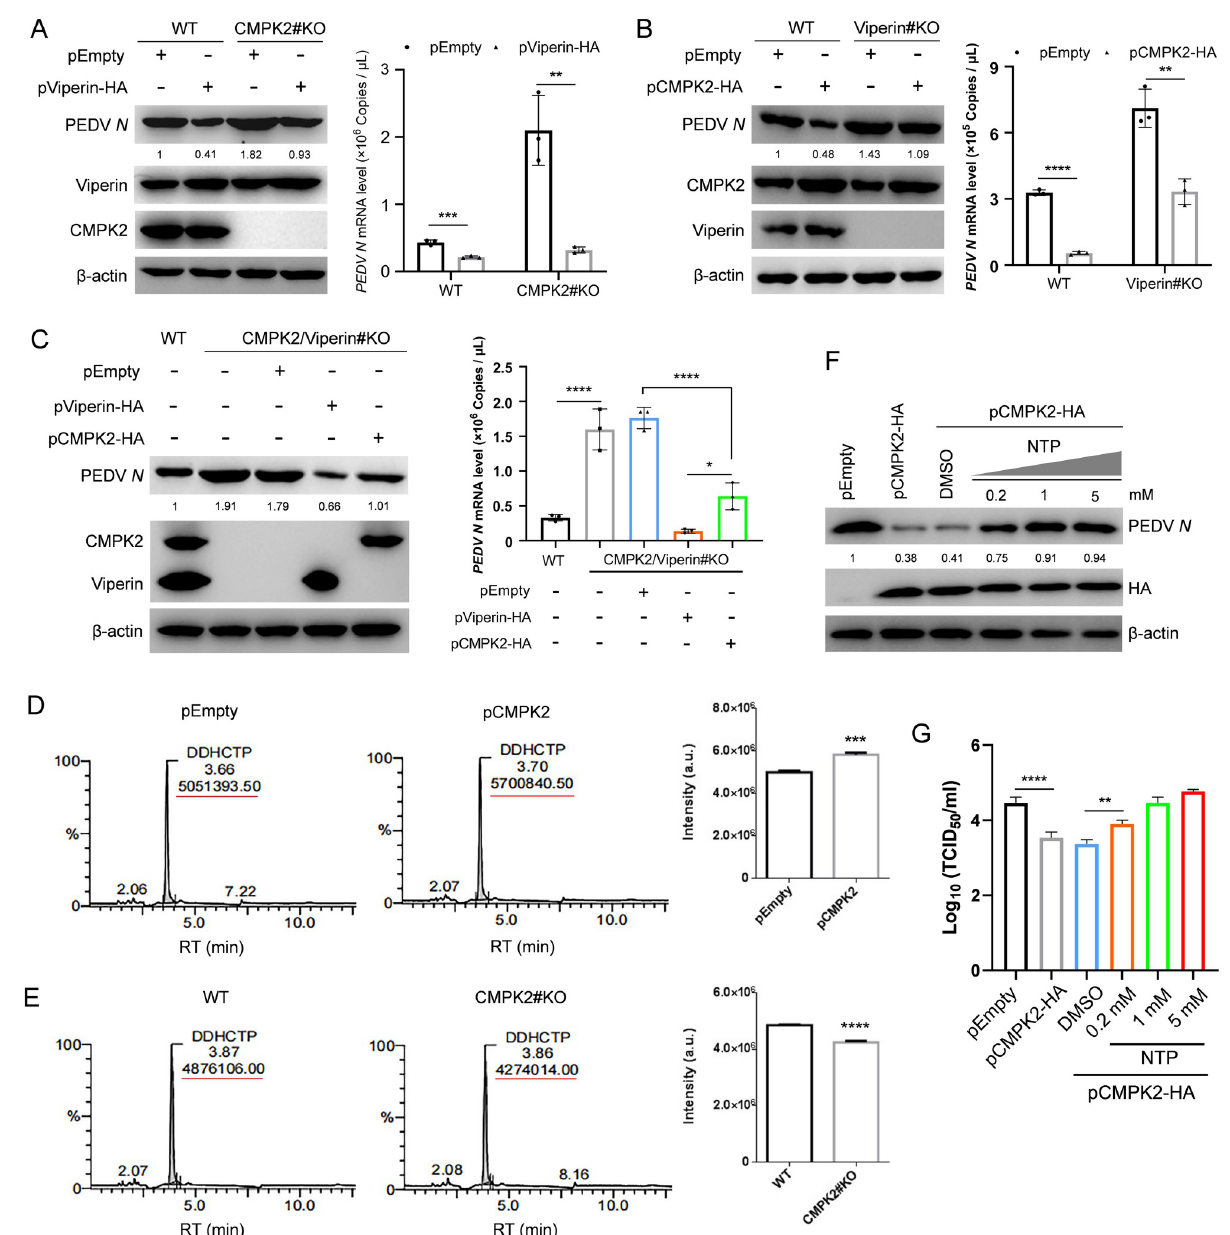
Fig 5. ddhCTP catalyzed by Viperin is crucial for CMPK2 inhibition of PEDV replication. (A) CMPK2#KO IPEC-J2 cells were transfected with pEmpty and pViperin-HA for 24 h and then infected with PEDV at MOI of 1. The cells were harvested at 20 hpi, and the lysates were analyzed by western blotting (left). Total RNA of the cells was extracted, and viral copy numbers were analyzed by qRT-PCR (right). (B) Viperin knockout (Viperin#KO) IPEC-J2 cells were constructed and then transfected with pEmpty and pCMPK2-HA for 24 h. Subsequently, Viperin#KO IPEC-J2 cells were infected with PEDV as above. The lysates were analyzed by western blotting (left). Total RNA of the cells was extracted, and viral copy numbers were analyzed by qRT-PCR (right). (C) CMPK2/Viperin double KO ( Viperin/CMPK2 #KO) IPEC-J2 cells were constructed and, respectively, transfected with pEmpty, pViperin-HA, and pCMPK2-HA for 24 h to rescue Viperin or CMPK2 expression and then infected with PEDV as above. The lysates were analyzed by western blotting (left). Total RNA of the cells was extracted, and viral copy numbers were analyzed by qRT-PCR (right). (D) ddhCTP production in IPEC-J2 cells with or without CMPK2 expression was determined by LC–MS. (E) The detection of ddhCTP production in CMPK2 knockout or wild-type IPEC-J2 cells by LC–MS. (F and G) IPEC-J2 cells were transfected with pCMPK2-HA and empty vector, and a range of concentrations of NTPs were added to compete with ddhCTP. The cell lysates were analyzed by western blotting ( F ), and PEDV titers in the culture supernatants were measured as TCID 50 ( G ). Data are means ± SD of triplicate samples; statistical analysis was conducted using one-way ANOVA followed by Dunnett’s multiple comparison test or two-way ANOVA followed by Tukey’s multiple comparison test; only the p -value for the most relevant comparisons are shown for simplicity. The intensities of bands were quantified by ImageJ. � p < 0.05, �� p < 0.01, ��� p < 0.001, ���� p < 0.0001.